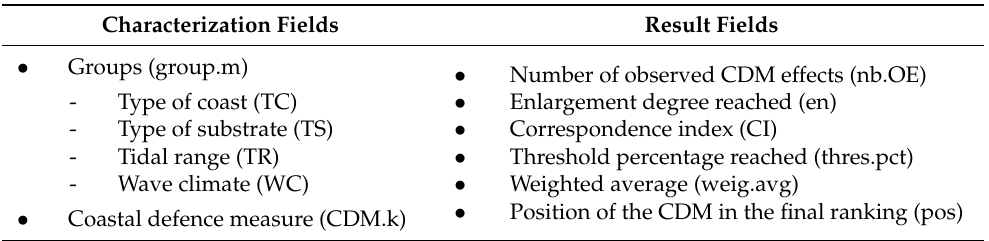
Table 8. Fields with their list of evaluation criteria.